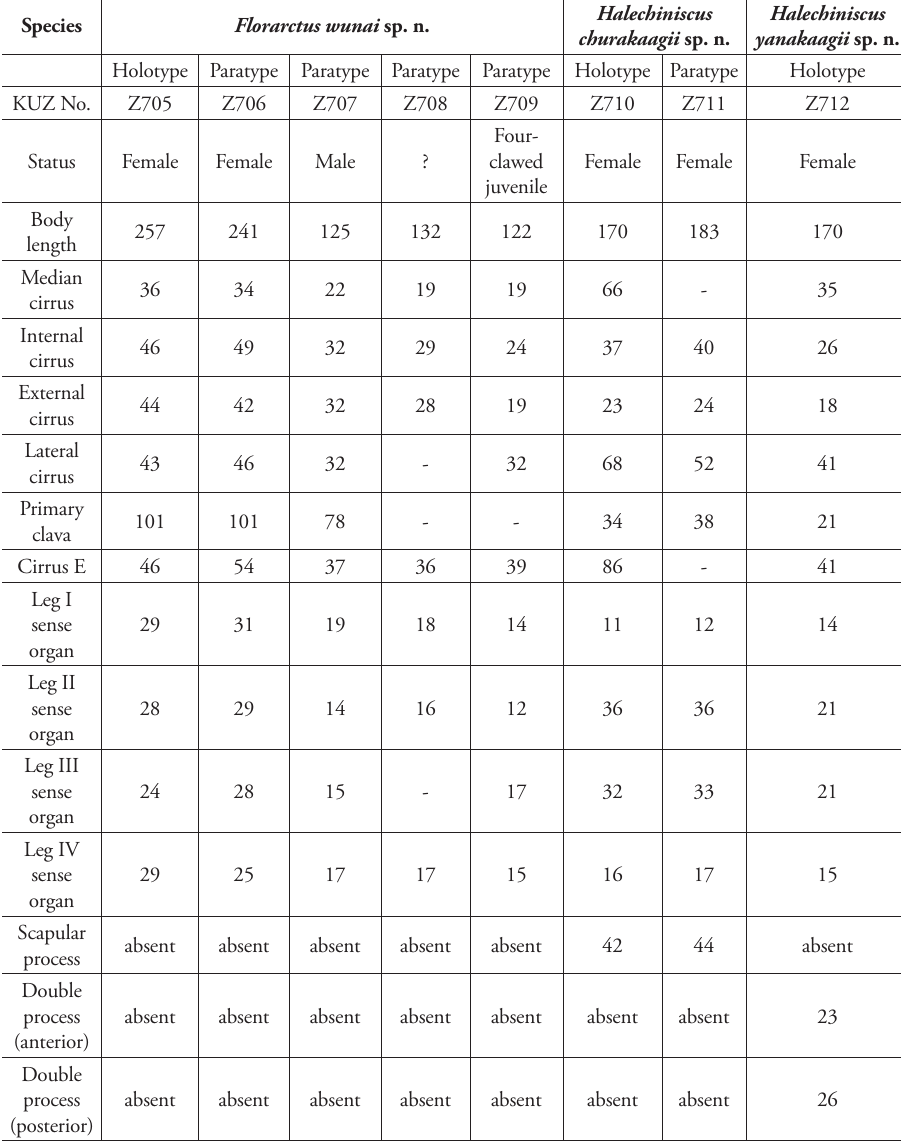
Table 2. Morphometrics of the three new species (measurements in μm). Dashes indicate unmeasured trait. Species Florarctus wunai sp.